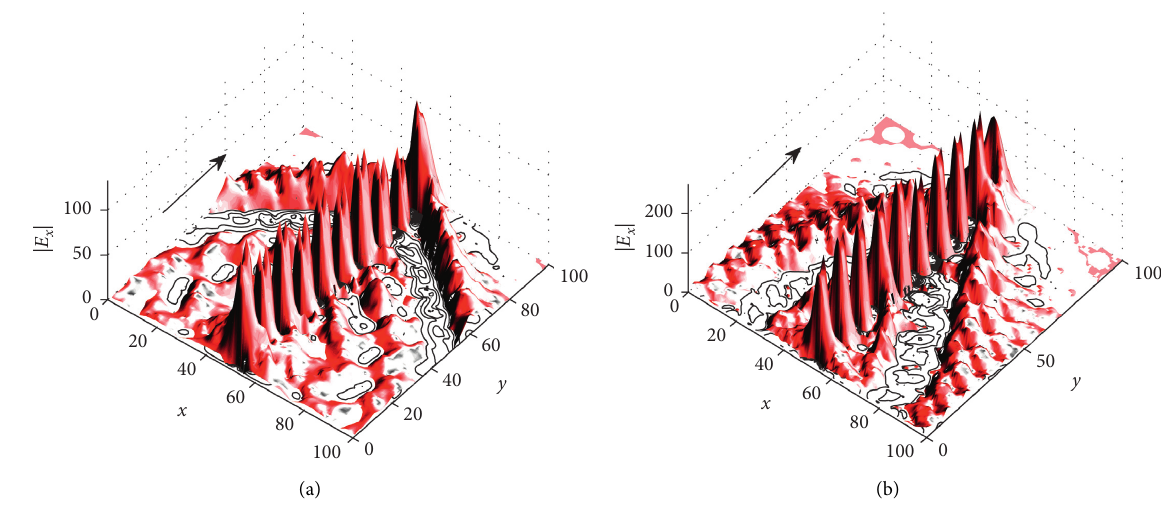
Figure 2: (Color on line) snapshots the field | E (a) r � 0 . 25, ε s � 3. (b) r � 0 . 35, ε s � 15. The Cherenkov group cone is well defined with oscillations in the path of the